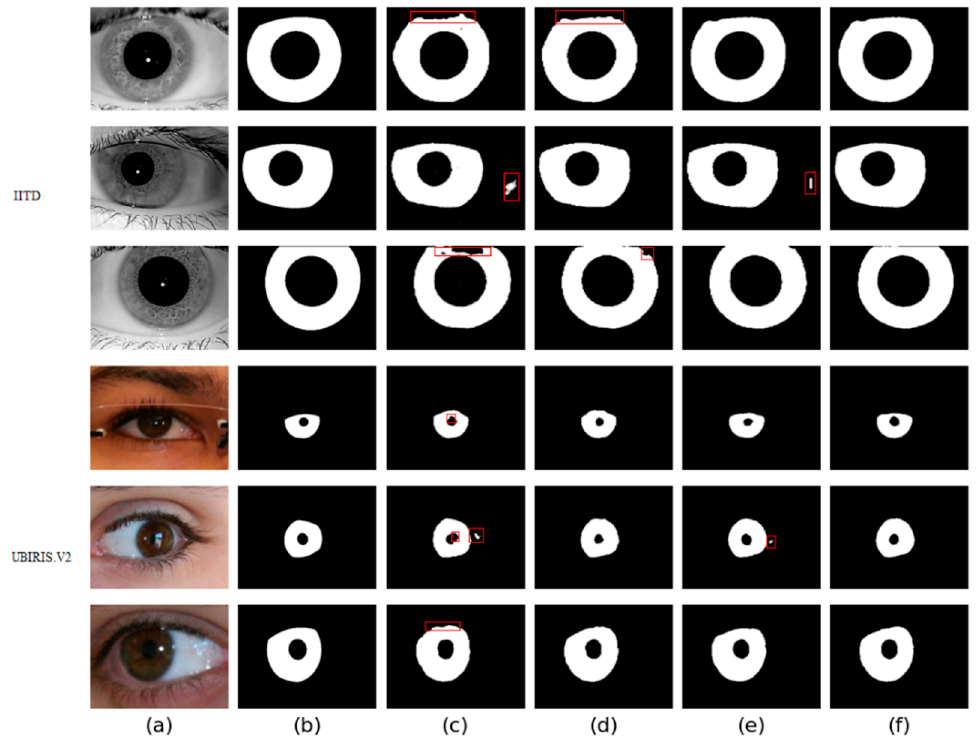
Figure 9. Segmentation results of different networks on two databases: ( a ) Original image, ( b ) Ground truth, ( c ) Results of baseline network, ( d ) Results of baseline network based on CAMM, ( e ) Results of baseline network based on MFIEM, and ( f ) Results of the proposed network.